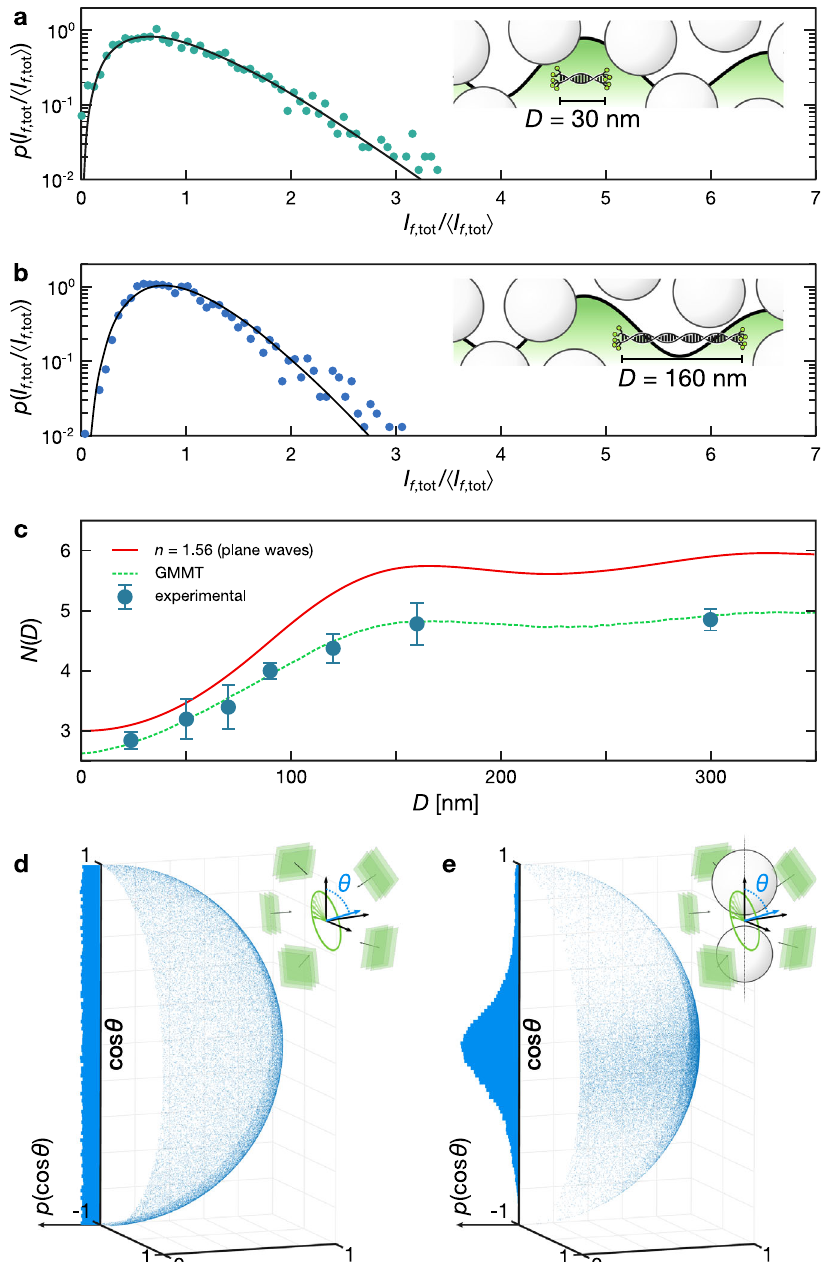
Fig. 3 Dependence of the probability density function on nanoruler size: turbid medium. a , b Experimental probability density function for D = 30 nm and 160 nm fi tted with Eq. (1) (inset drawing not to scale). c N ( D ) dependence obtained from a simple plane wave calculation (solid, red) and from generalized multiparticle Mie theory (GMMT) calculations (dashed, green). Full circles correspond to experimental data points, with an uncertainty estimated by averaging the results of 8 different nanorulers. d , e Average angular distribution of the unit vector normal to the polarization ellipse under isotropic illumination in a homogeneous effective medium and at a position between two scattering particles. The blue arrow in the sketches is parallel to the propagation direction and normal the polarization ellipse swept by the electric fi eld (green